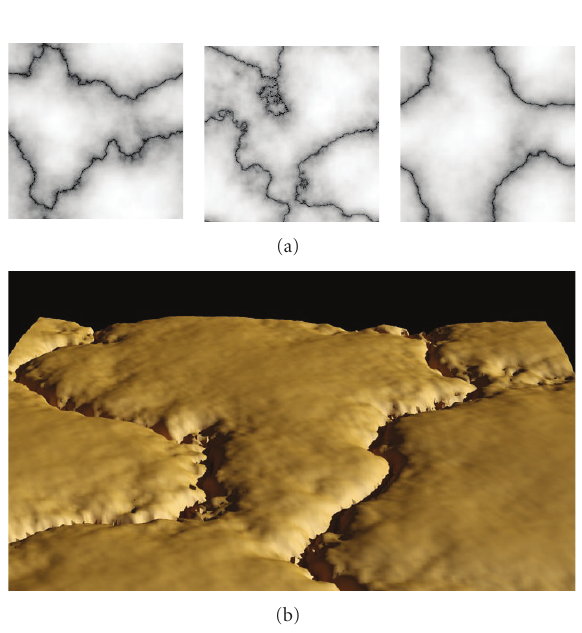
Figure 10: Family of terrains from TP in (2): (a) represented as grey-scale images, (b) rendered with 3D studio.